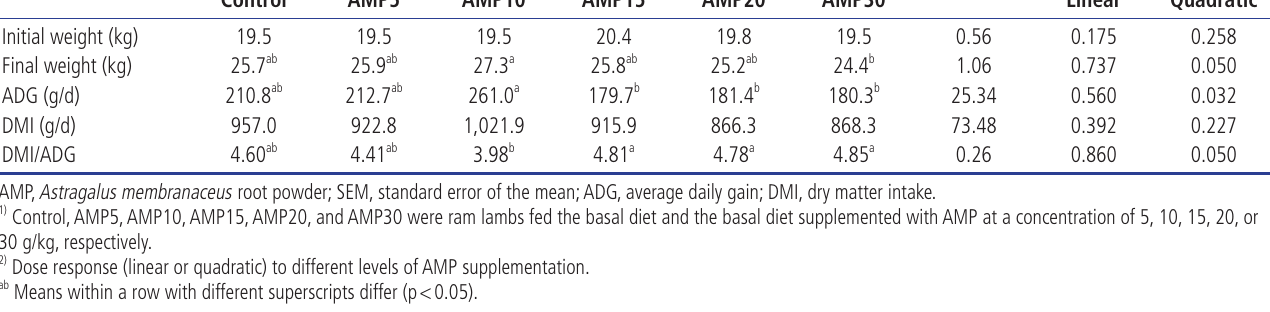
Table 2. Effects of Astragalus membranaceus roots on dry matter intake and growth performance of ram lambs Items